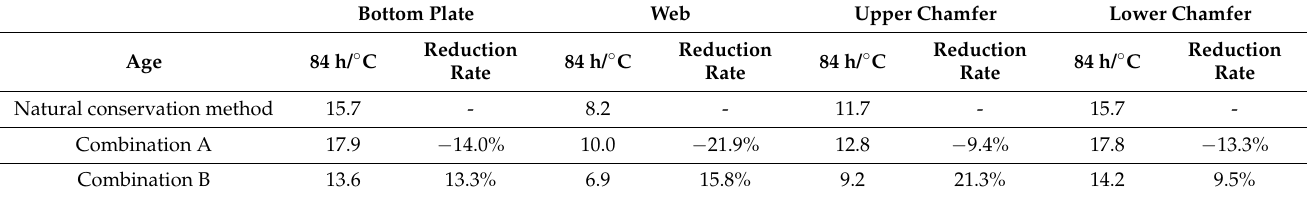
Table 4. Peak temperature variation of box girder using different curing methods after